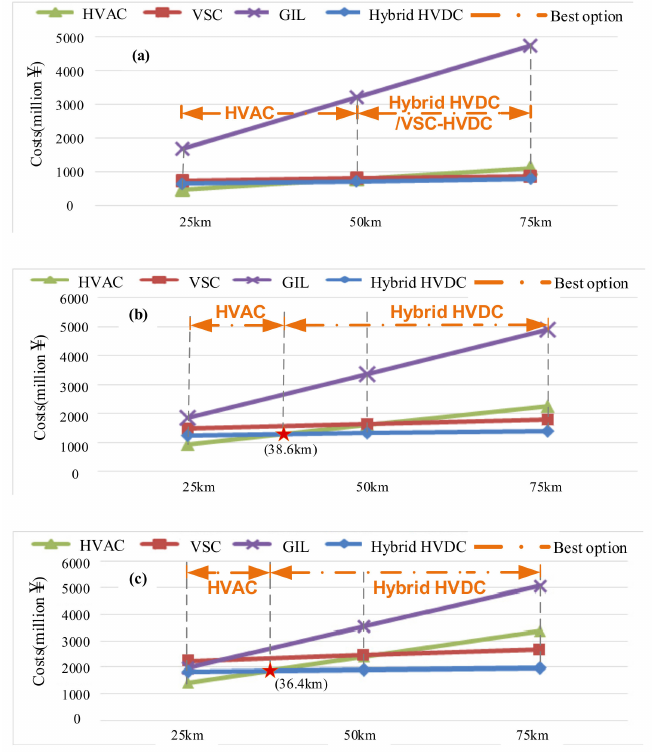
Figure 3. Total costs of different L of 300 MW, 600 MW, and 900 MW wind farms: ( a ) shows the 300 MW offshore wind farm total costs with different distances; ( b ) shows the 600 MW offshore wind farm total costs with different distances; ( c ) shows the 900 MW offshore wind farms total costs with different